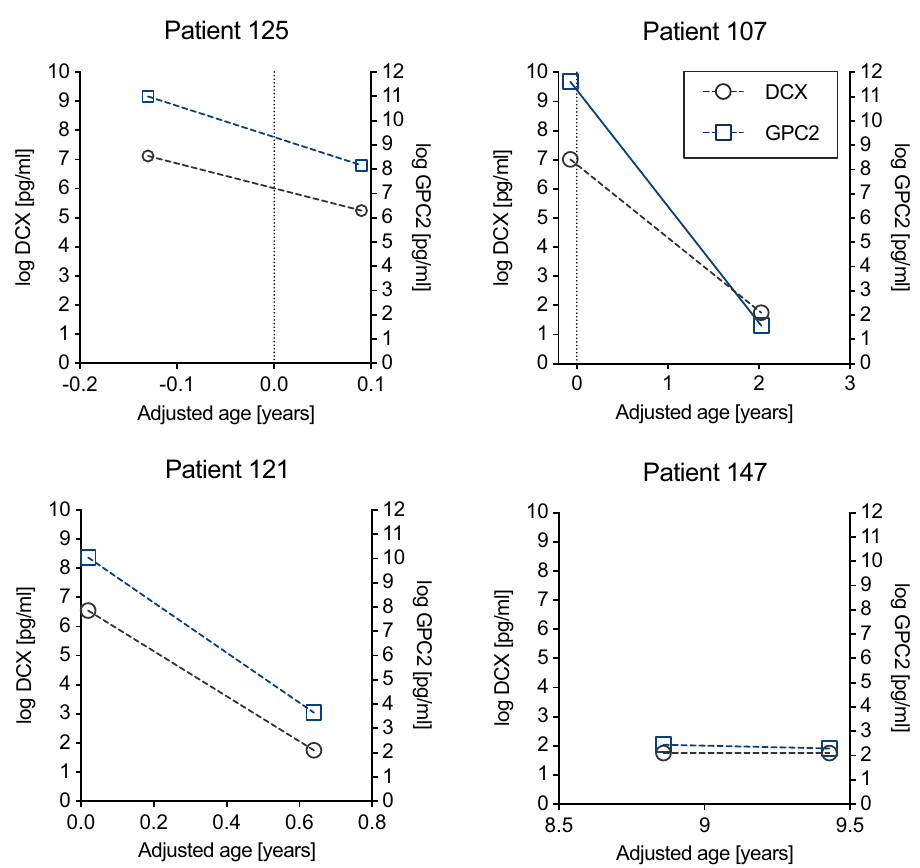
Fig 3. The overall age-related decline in CSF-DCX and CSF-GPC2 can also be observed in individual patients with repeated CSF collection. Graphs for patients 125, 107, 121 and 147 are displayed as representative examples. The DCX datapoints that were below the LOD are displayed as the mean LOD (5.8